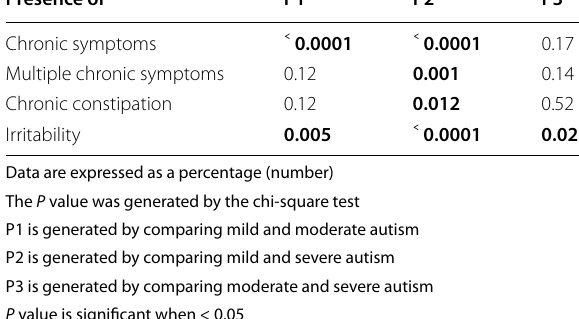
Table 9 The percentage of children with positive lab results